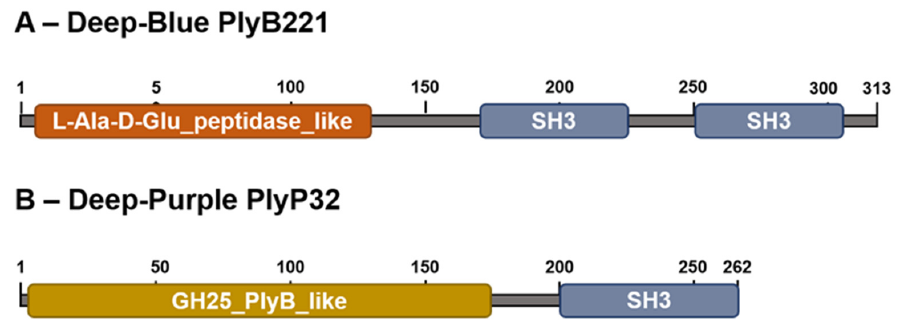
Figure 1. In silico analysis of Deep-Blue PlyB221 and Deep-Purple PlyP32. ( A ) PlyB221 two domain organization. The EAD is a putative L-Ala-D-Glu peptidase domain (superfamily Peptidase_M15) and the CBD contains two potential SH3 domains (superfamily SH3). ( B ) PlyP32 displays a GH25_PlyB_like domain as EAD (GH25 superfamily) characteristic of a muramidase activity and a single SH3 domain as CBD.